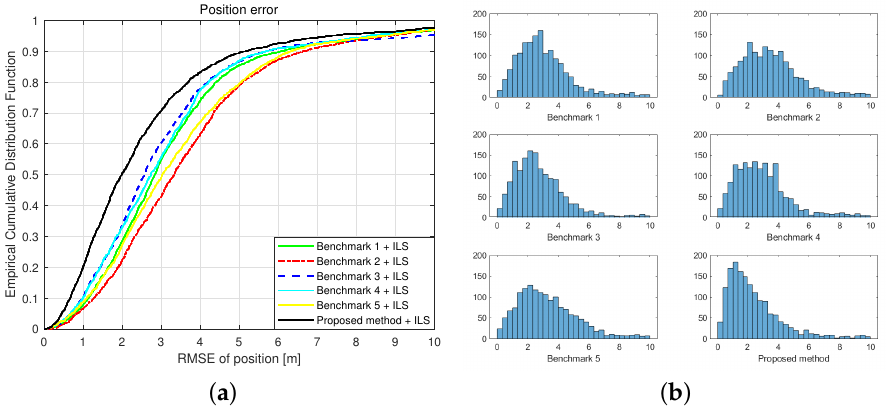
Figure 12. A top view of the test environment. Our proposed method is more effective for errors of the 50th percentile or less. The histogram in Figure 13b shows the distribution of spatial positioning errors. In each his- togram, the x-axis represents positioning RMSE, and the y-axis represents count. The result shows that proposed method improved the overall positioning accuracy, and increases the number of cases estimated within 2 m. This is because the proposed algorithm effectively reduces the ranging error when the AP and the target device are actually close to each other, but are blocked by walls.